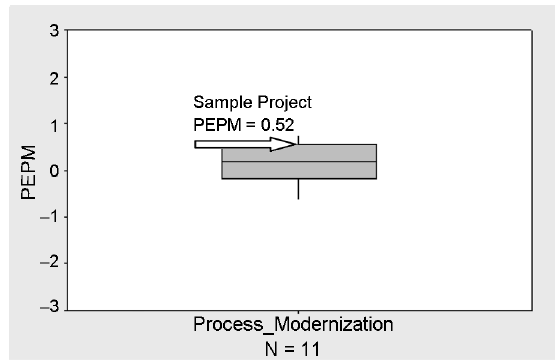
Fig. 6. Benchmarking at the project level